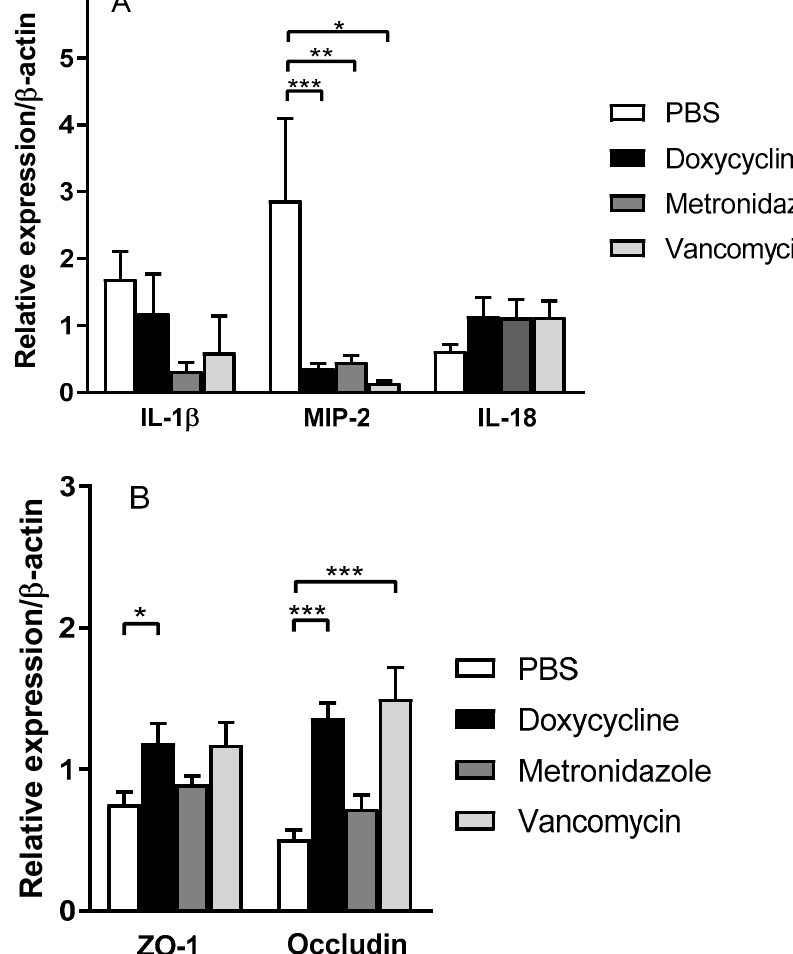
Figure 5. RNA expression of cytokines ( A : interleukin [IL]-1 β , macrophage inflammatory protein [MIP]-2, and IL-18) and tight junction proteins ( B : zonula occludens [ZO]-1 and occludin) genes in colonic tissue of Clostridioides difficile -infected mice receiving PBS, doxycycline, metronidazole, or vancomycin therapy. The values are expressed as the means ± standard errors ( A : *, p = 0.035; **, p = 0.033; ***, p = 0.018; B : *, p = 0.024; ***, p < 0.0001).